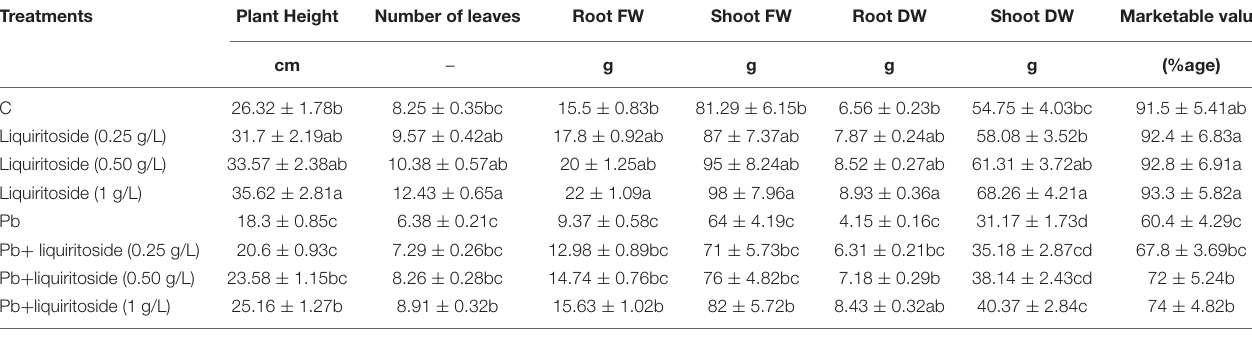
TABLE 1 | Effect of liquiritoside on growth attributes of Chinese flowering cabbage plants under lead (Pb) stress. Treatments Plant Height